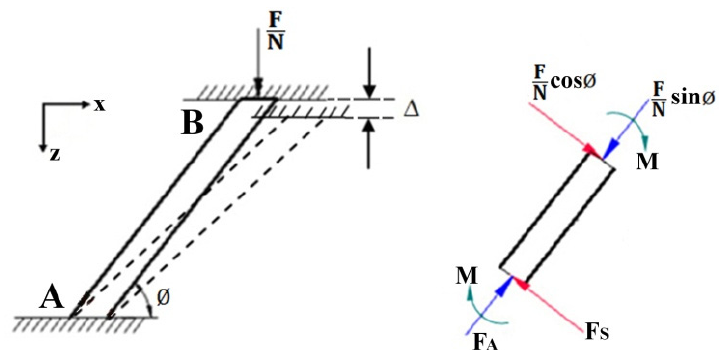
Figure 9. Force analysis of a single core